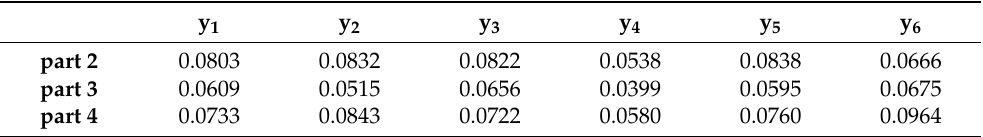
Table 4. Mean absolute error of transformation parameters using pointnet++ as feature extractor and distance error loss for training. Note that y 1 –y 6 are the six rigid transformation parameters defined by axis and angle.